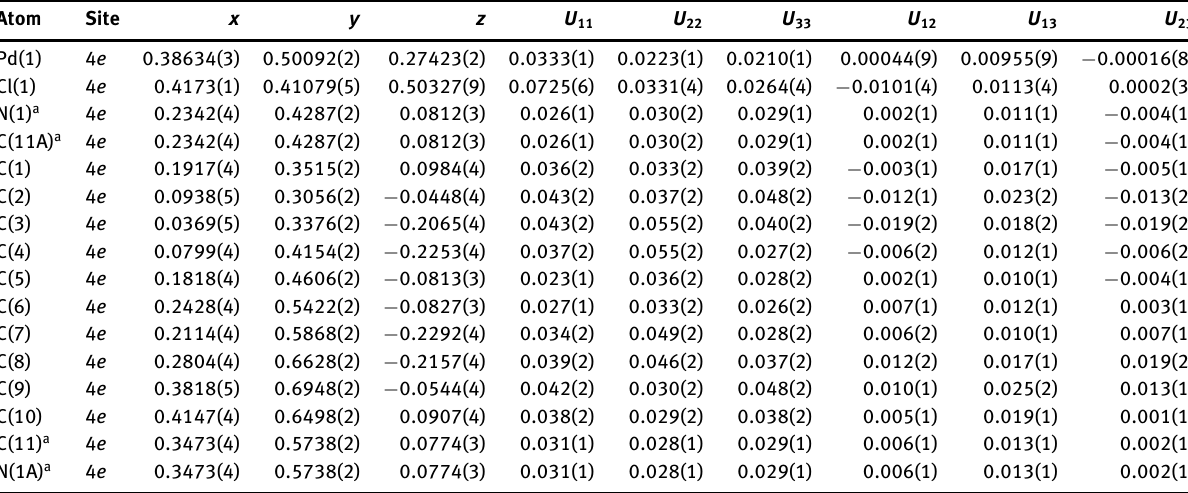
Table 3: Atomic coordinates and displacement parameters (Å 2